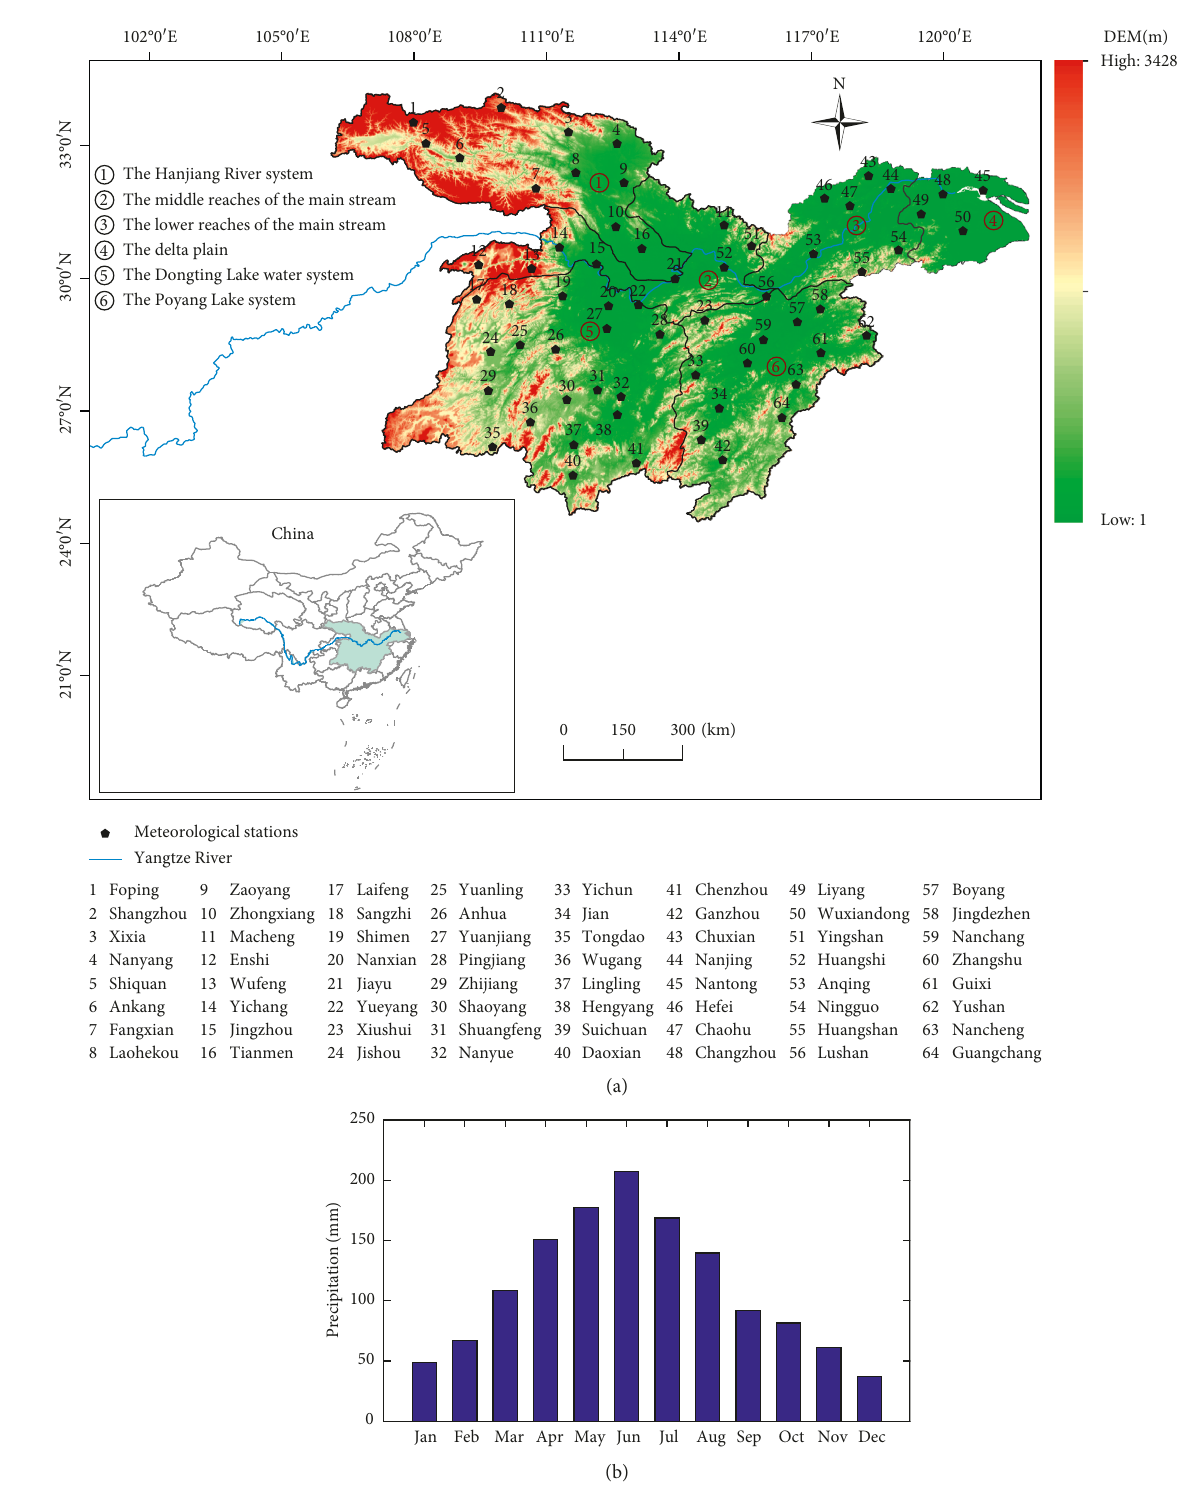
Figure 1: (a) The location of the MLRYRB; (b) monthly mean precipitation averaged over the MLRYRB for the period